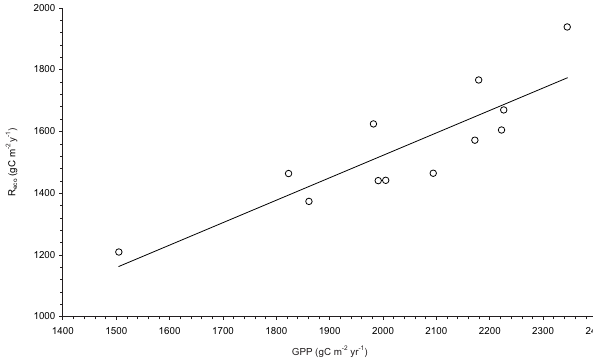
Fig. 7. Relationship between annual R eco and annual GPP ( r 2 = 0.74, p < 0 . 001).